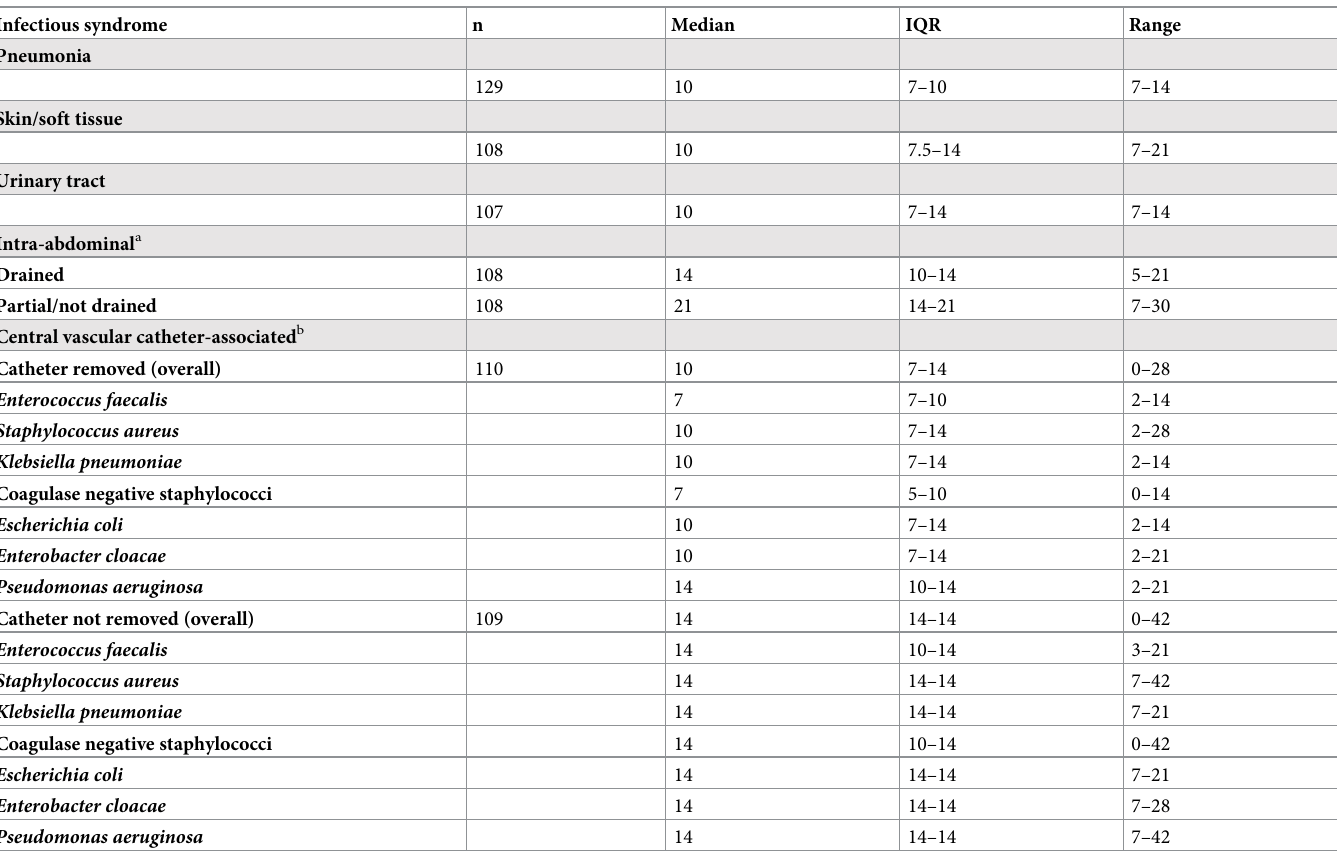
Table 1. Recommended treatment duration (days) by infectious